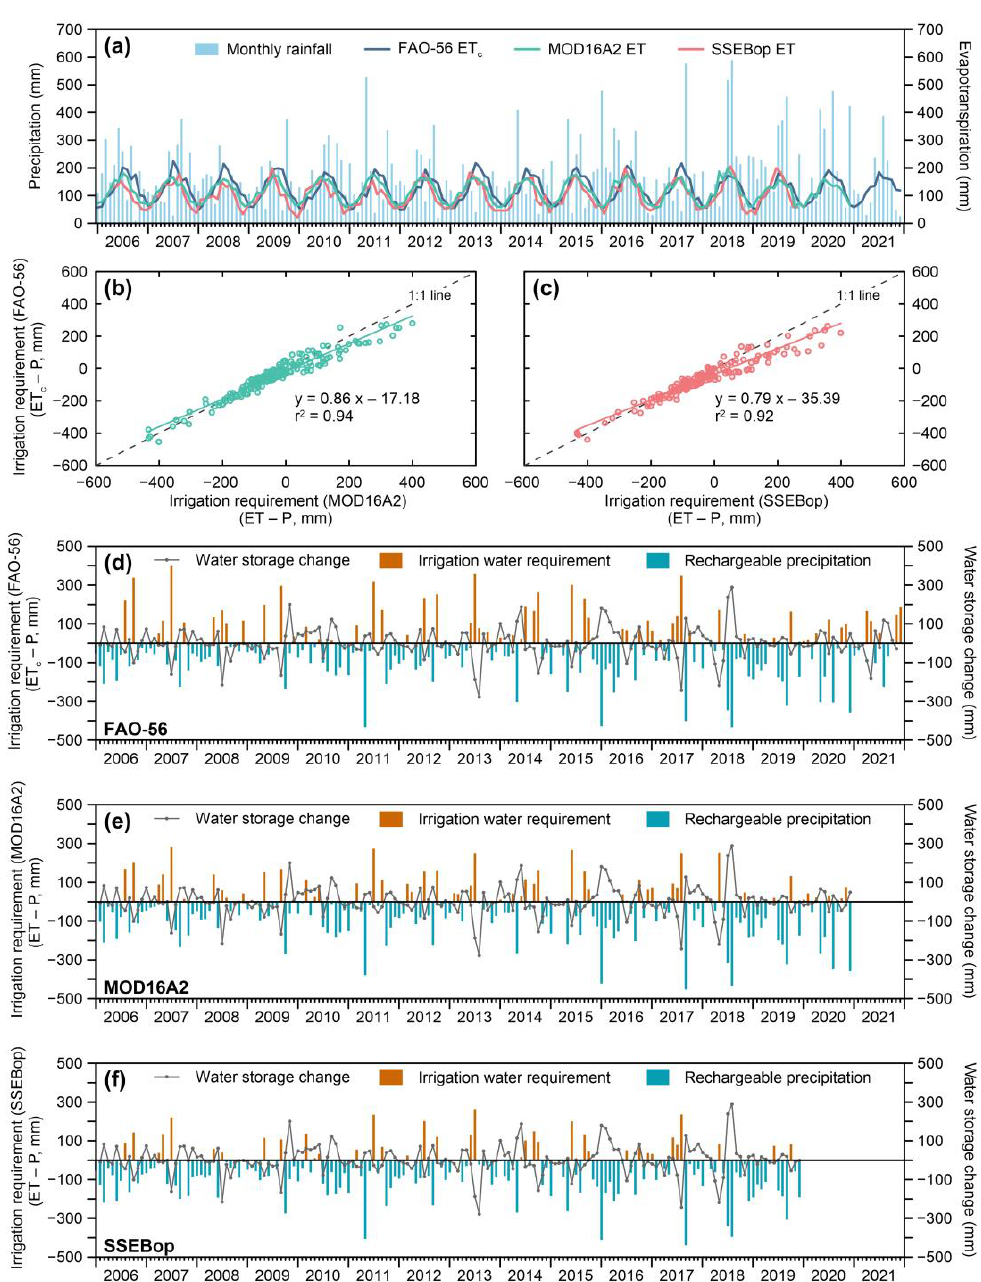
Figure 6. ( a ) Fluctuations in monthly rainfall and evapotranspiration (FAO-56-based ETc,